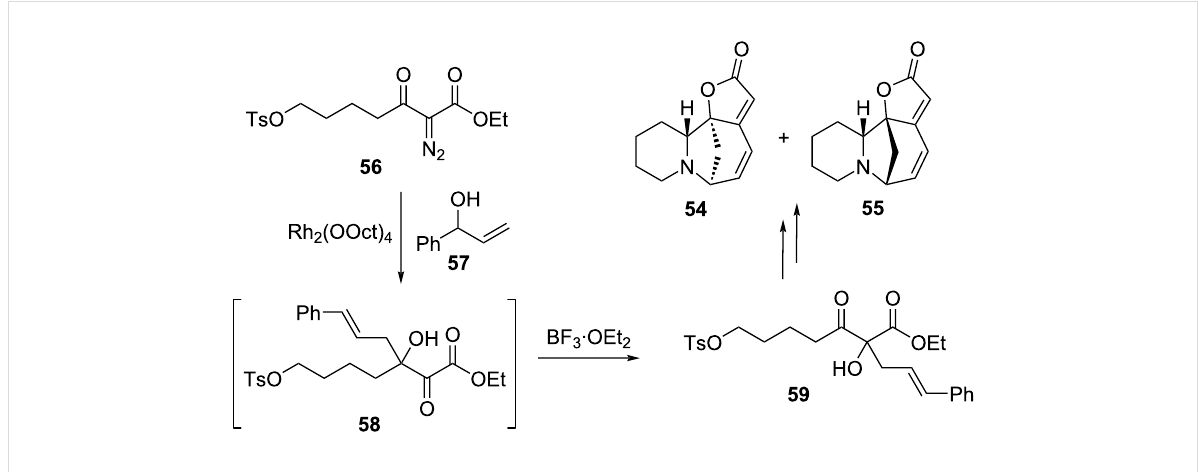
Figure 13: Single-pot reaction consisting of Claisen and α -ketol rearrangements, part of the total synthesis of (±)-securinine ( 54 ) and (±)-allosecuri- nine ( 55 ).